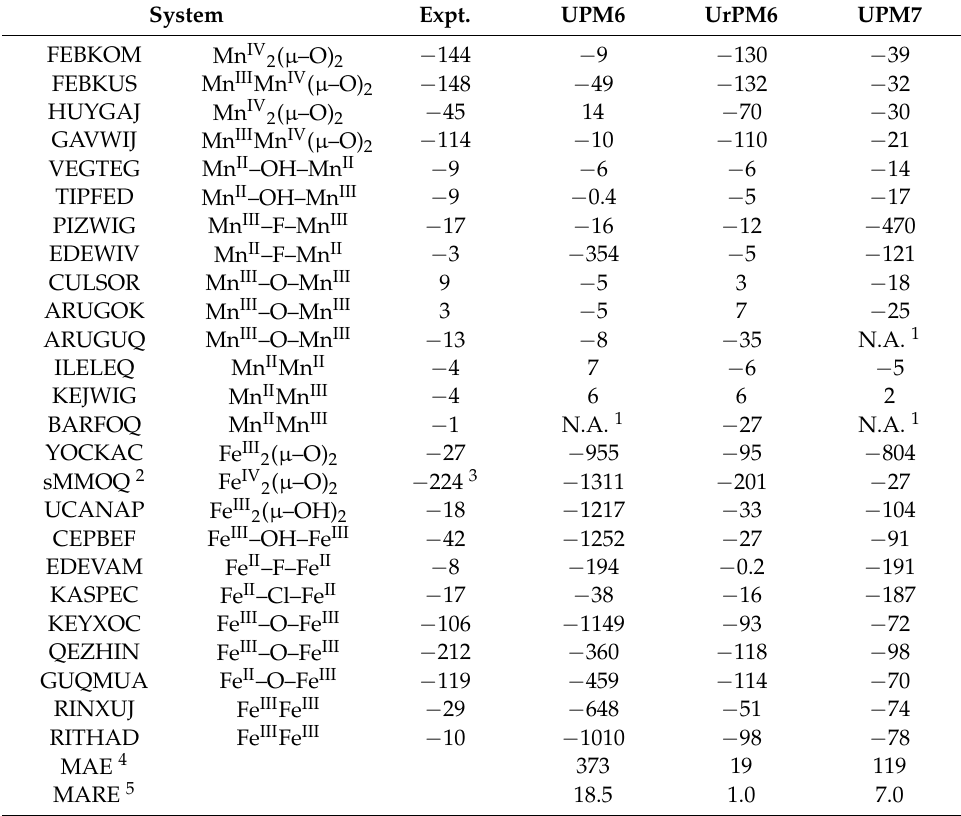
Table 2. Magnetic exchange coupling constants (in cm − 1 ) for 25 dinuclear metal